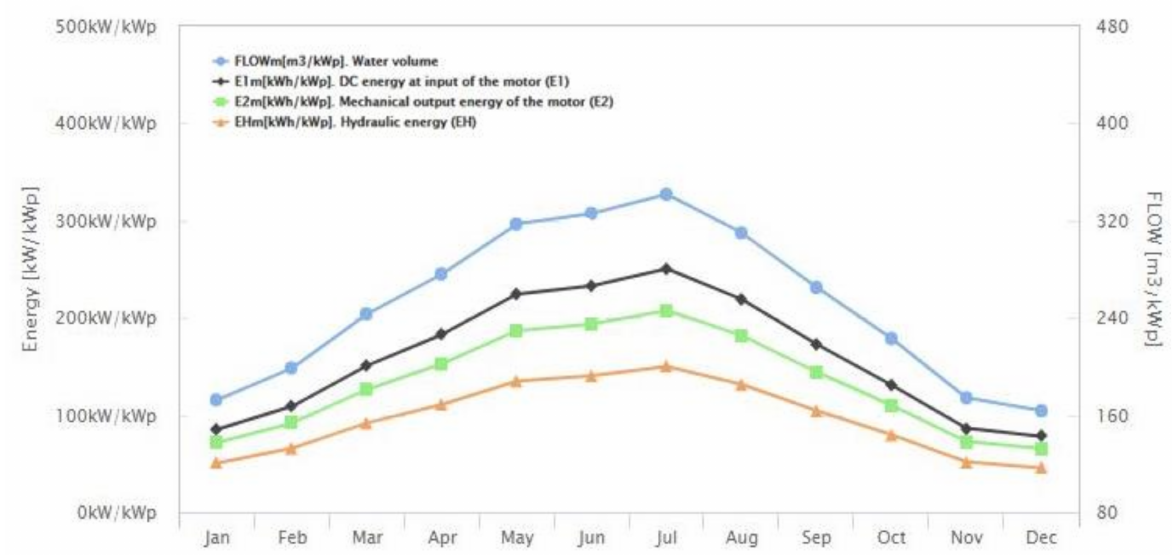
Figure 12. The global performances of the PV pumping system for a specific site in